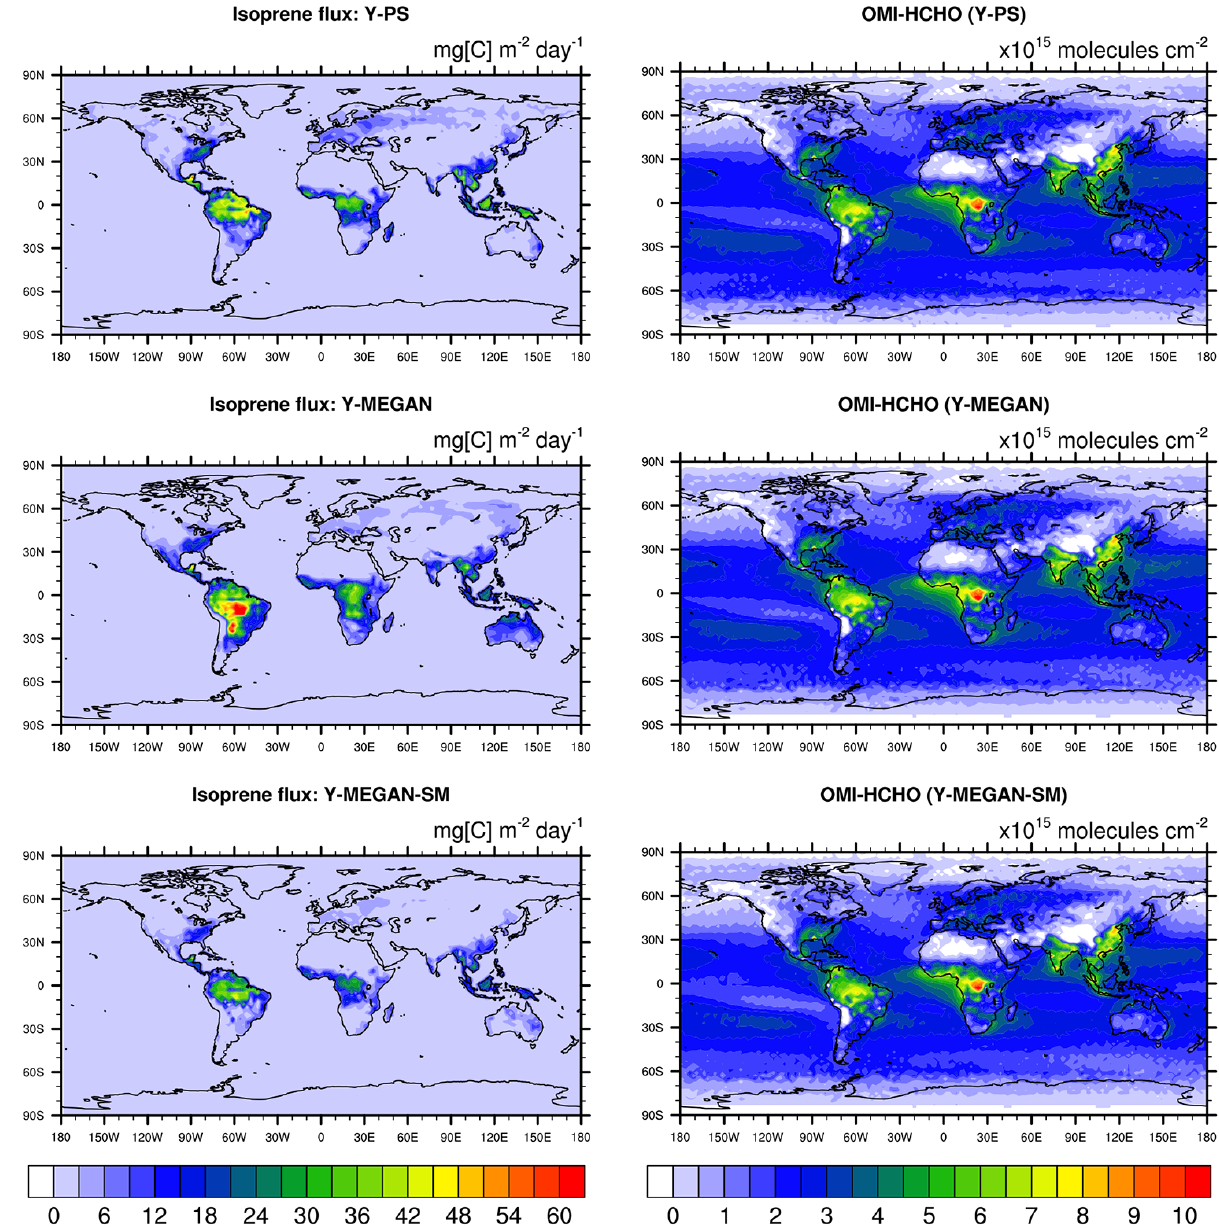
Figure 1. Left column: simulated annual mean isoprene flux (mg[C]m − 2 day − 1 ) in models Y-PS, Y-MEGAN and Y-MEGAN-SM. Right column: satellite-based HCHO columns ( × 10 15 moleculescm − 2 ) from OMI processed using air-mass factors of models Y-PS, Y-MEGAN and